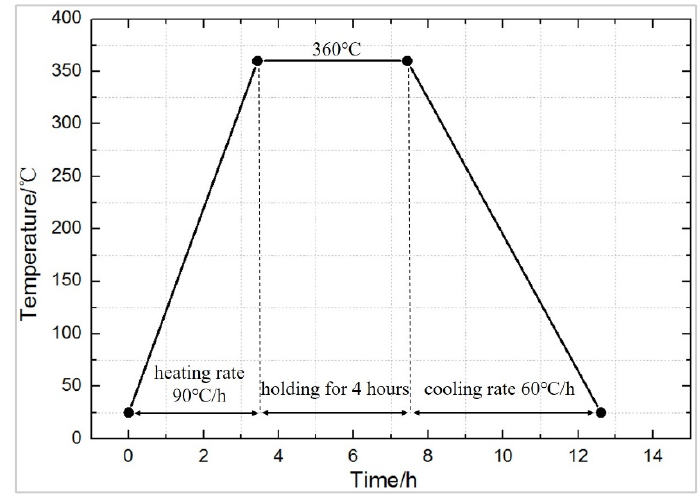
Figure 1. The typical preparation process of reactive materials.